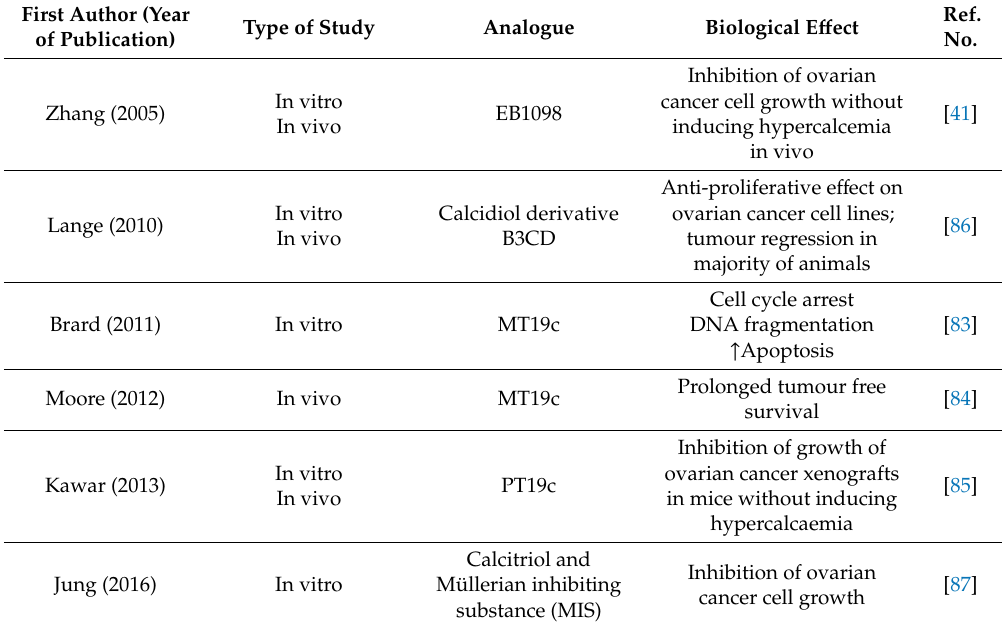
Table 2. Description of studies on the use of calcitriol and its analogues for the inhibition of ovarian cancer cell growth. See text for